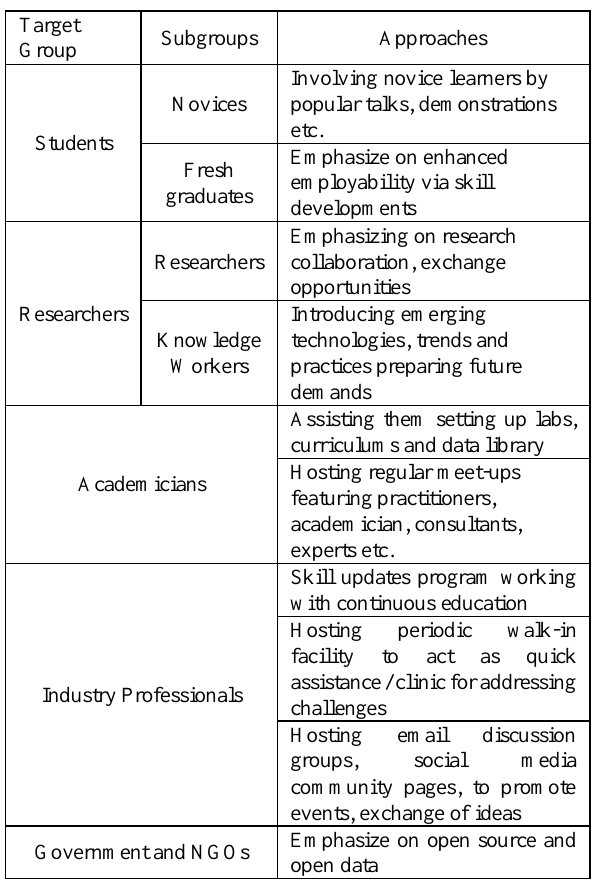
Table 4: Recommended approaches for target groups The analytical study resulted in delineation of different target groups, which thereafter brought insights out of curriculum, pedagogy and evaluation based strategies for target groups and finally ended on the note of some recommended interventions which enhance their capabilities in this